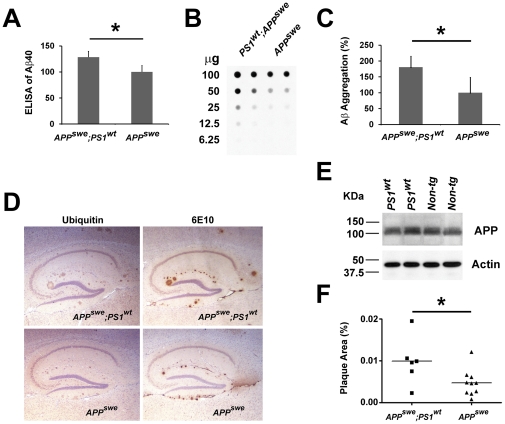
Increase in generation and deposition Aβ in the brains of APPswe;PS1 mice.(A) ELISA analysis of Aβ40 peptides in the protein extracts of brains of PS1 and non-transgenic control mice. The data were average +/− SEM from 5 mice for each genotype. (B) Sagittal brain sections (10 µm) of hippocampus area of 22-months old APPswe;PS1 and APPswe female mice. The Aβ plaques were visualized by immunostaining with antibodies specific to ubiquitin and Aβ peptides (6E10). (C) Quantitative analysis of the levels of Aβ aggregation in the brains of APPswe;PS1 and APPswe mice at 22 months of age by filter trap assay. (D) Quantification of the signals of Aβ aggregations in the filter trap assay using Image J program. (E) Analysis of Aβ deposition using unbiased stereology in the hippocampus of 22-months old APPswe;PS1 (n = 6) and APPswe (n = 10) female mice.